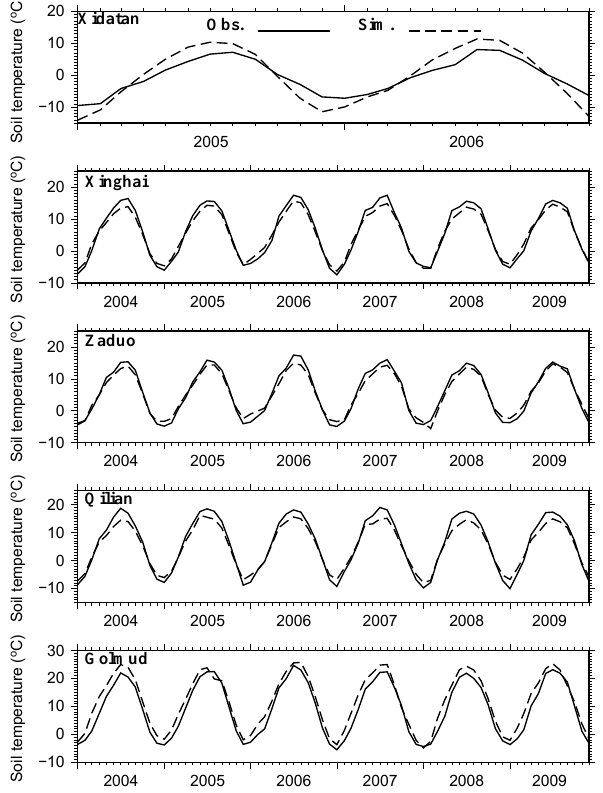
Figure 2. Simulated and observed monthly soil temperature at 5 calibration sites.